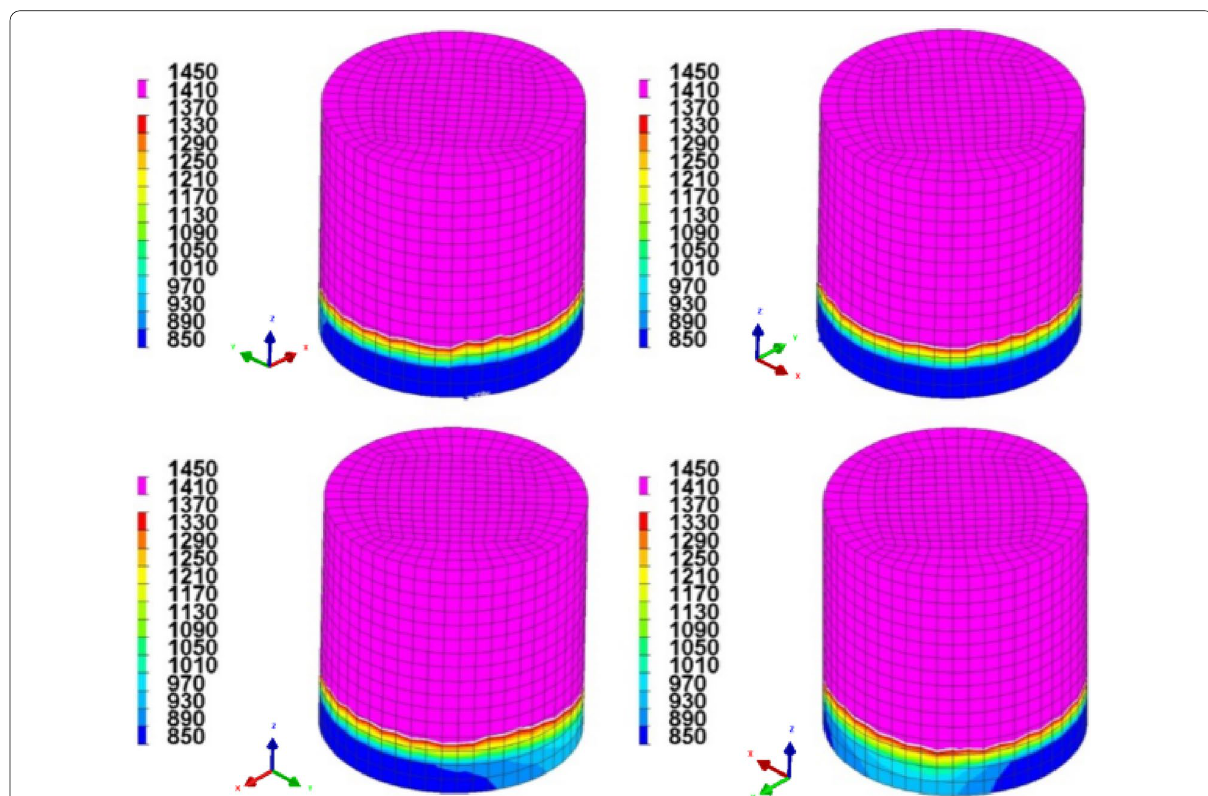
Figure 14 Temperature field distribution cloud map under the welding condition of 6-sections